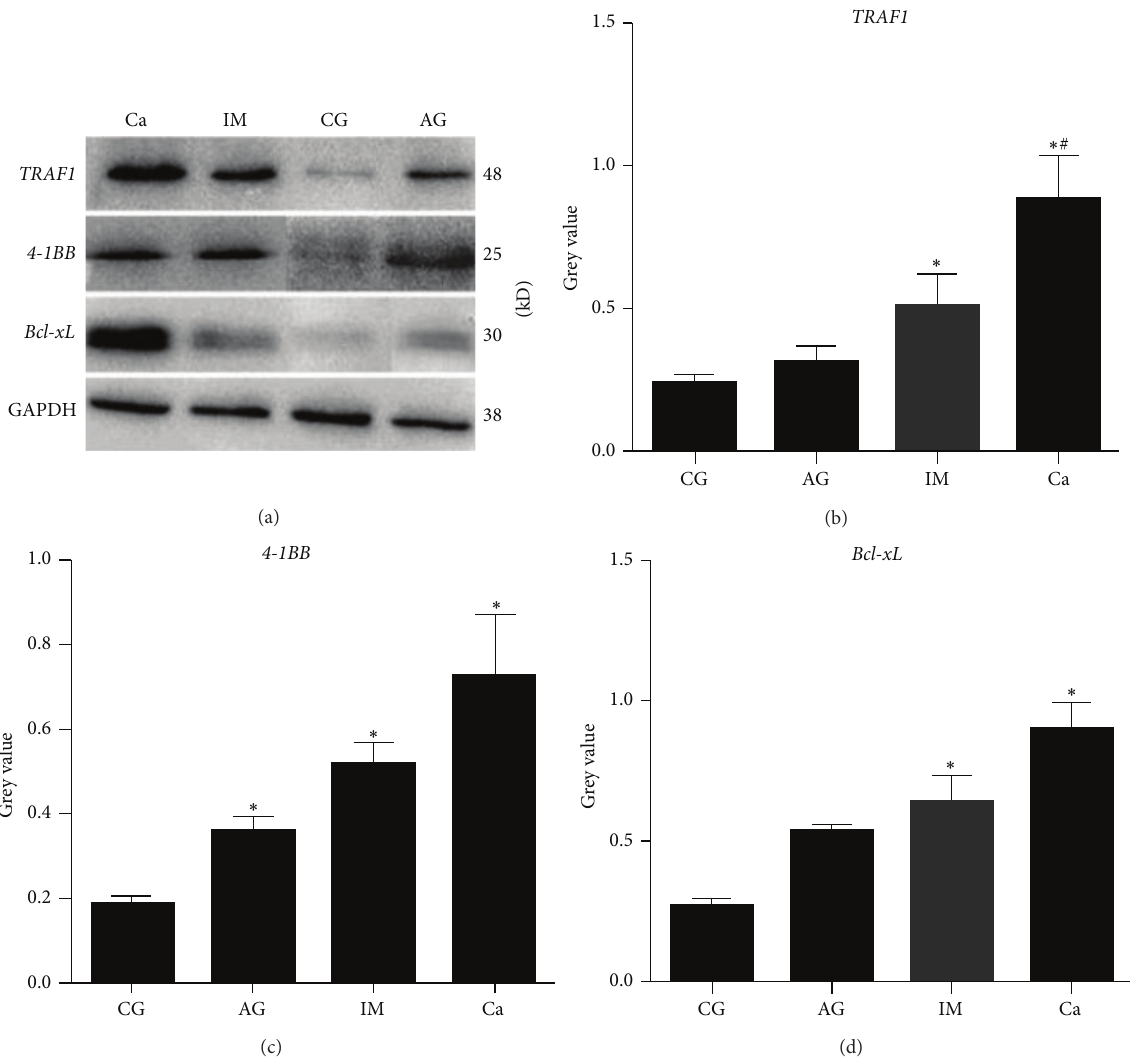
Figure 1: Western blotting examination of TRAF1, 4-1BB, and Bcl-xL protein expression in gastric mucosal tissue from subjects with CG, AG, IM, or Ca. (a) Representative western blots. Relative expression of (b) TRAF1 , (c) 4-1BB, and (d) Bcl-xL was quantified against GAPDH. Data were quantified from three independent experiments. ∗ 𝑃 < 0.05 compared with CG; # 𝑃 < 0.05 compared with